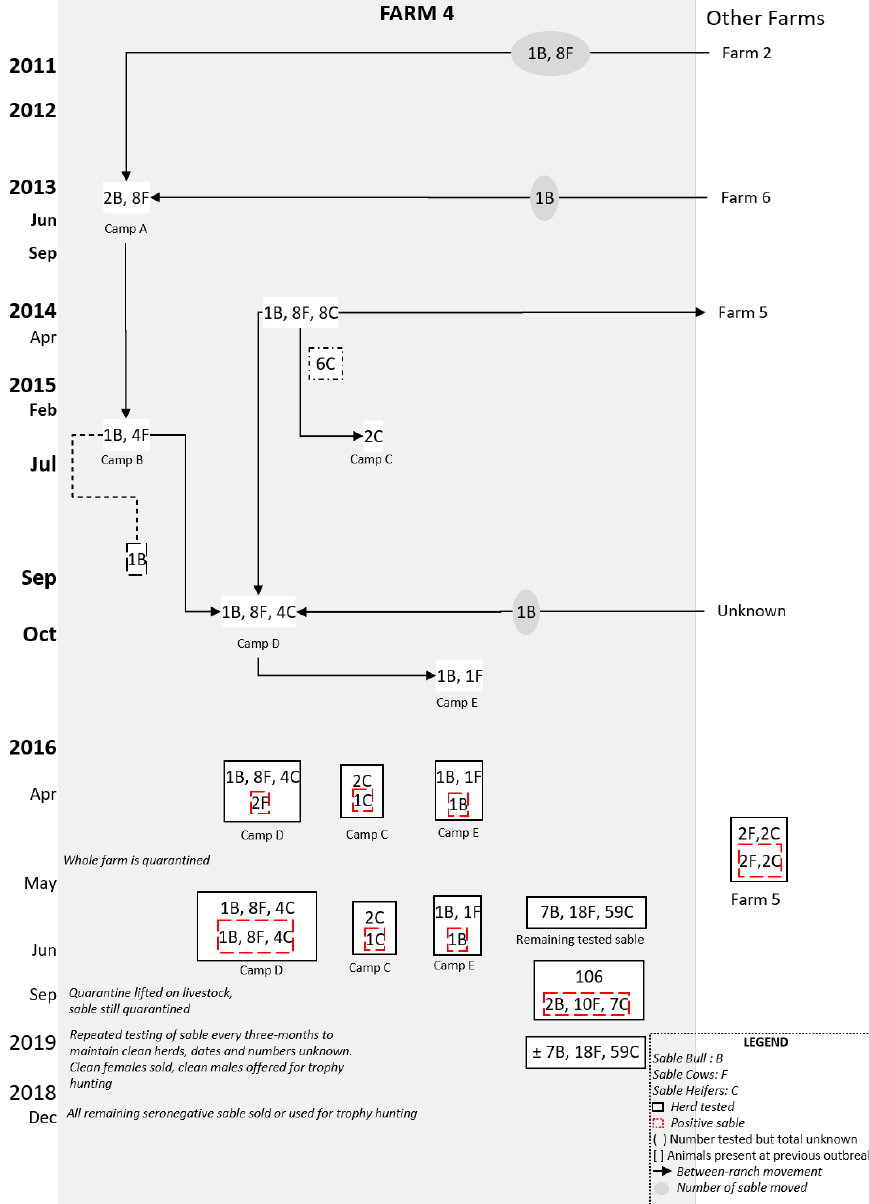
Figure 2. Flow diagram of postulated brucellosis spread in Farm 4 from 2011 to 2018. The sable (bull (B), cow (F), or heifers (C) on Farm 4 with movements (indicated by the grey circle) and groups are shown from 2011 to 2015 before the first brucellosis-seropositive animals were tested in 2016 (indicated by stipulated red